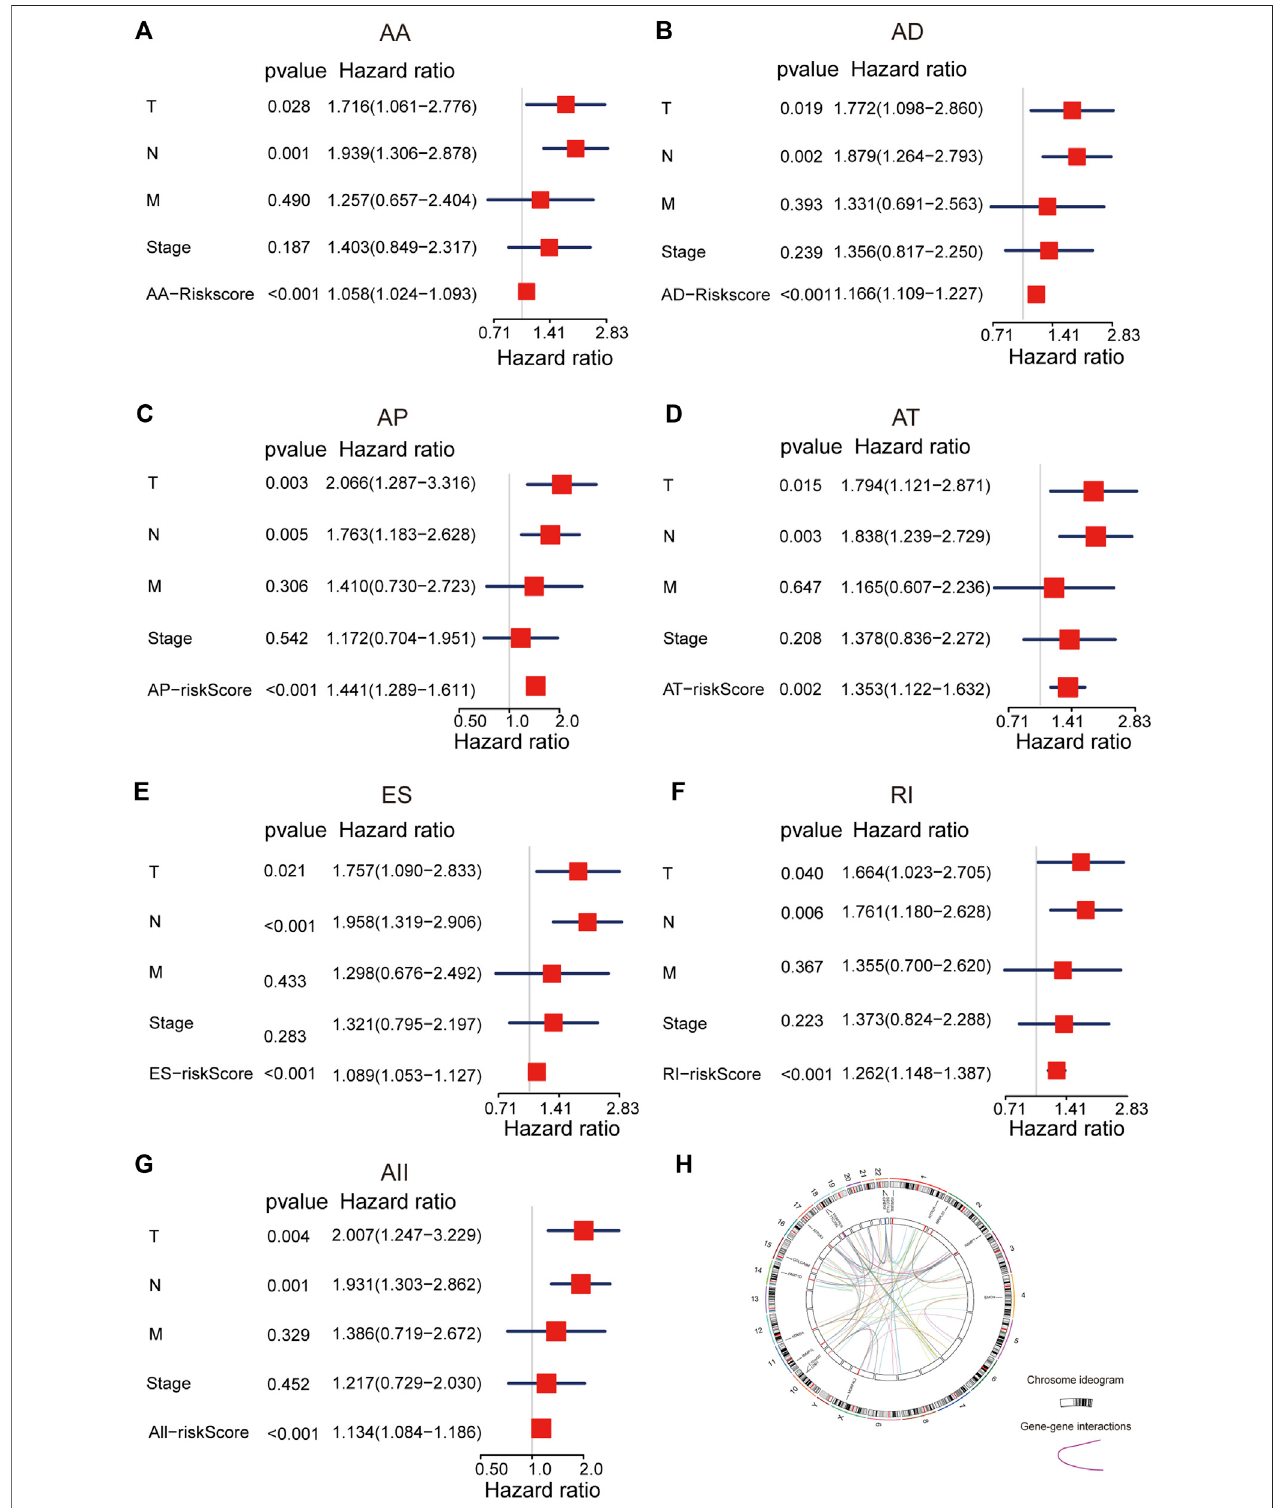
FIGURE 3 | The multivariate Cox analysis of AS signatures and clinical characteristics. (A – G) Forest plots of hazard ratios of risk scores and clinical characteristics from multivariate Cox analyses. (H) Circos plots of the detail of AS events and its interacting genes in chromosome.